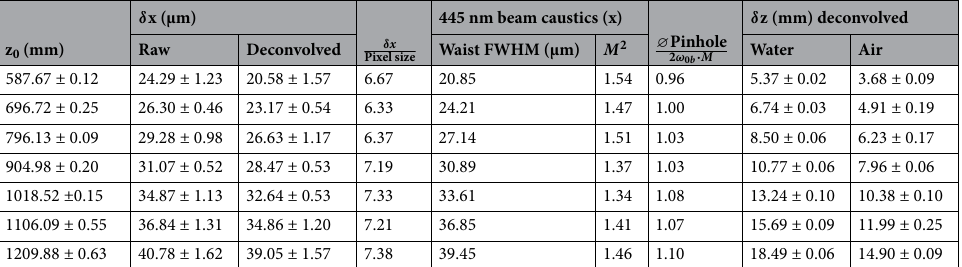
Table 2. Spatial resolution measurements and excitation beam caustics. The mean values for N = 5 measurements are given with respective deviations. For δ z , only the deconvolved results are included. ∅ Pinhole = 50 μm is the diameter of the circular pinhole aperture and 2 ω 0 b · M is the exp(− 2) excitation beam waist backpropagated to the probe